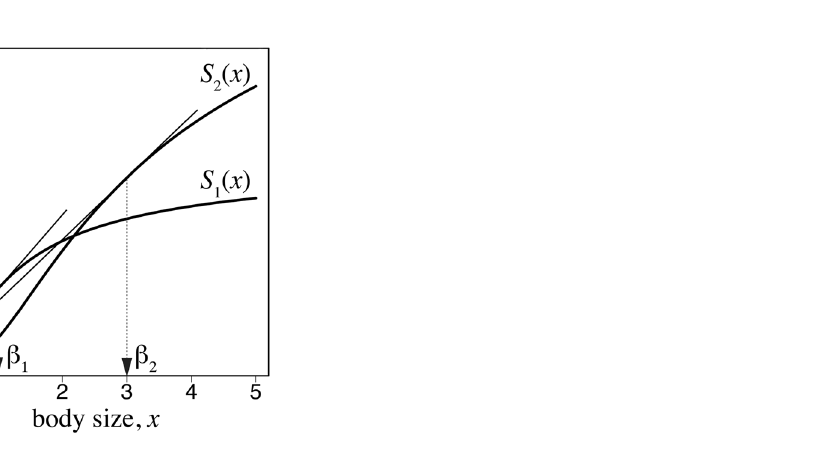
Figure 1. Number of workers engaging in two tasks as a function of age. The horizontal axis is a , i.e., the time since emergence (age polyethism). ( a ) There are two groups of workers, each specialized in one task (caste polyethism). ( b ) There is a single type of worker engaging in both tasks according to age. The parameters used are as follows: = . u